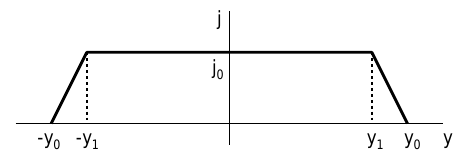
Figure 2. Profile of the surface current density j along a